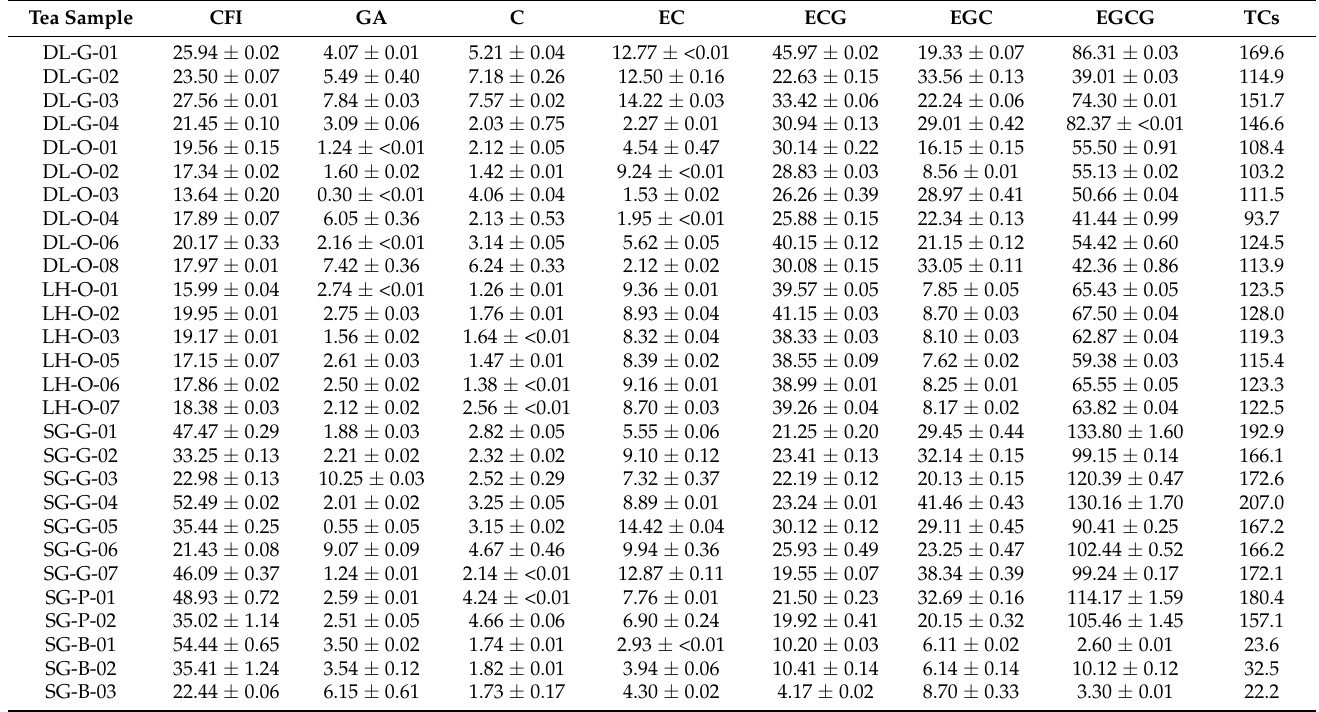
(Table 2). The observed variations in TPCs and TFCs are consistent with results published in previous studies [31,32]. Table 2. Concentration (mg g − 1 DM ± standard deviation) of caffeine (CFI), gallic acid (GA), catechin (C), epicatechin (EC), epicatechin gallate (ECG), epigallocatechin (EGC), and epigallocatechin gallate (EGCG), and total catechins (TCs) in various dried tea products of different geographical origins and varieties in